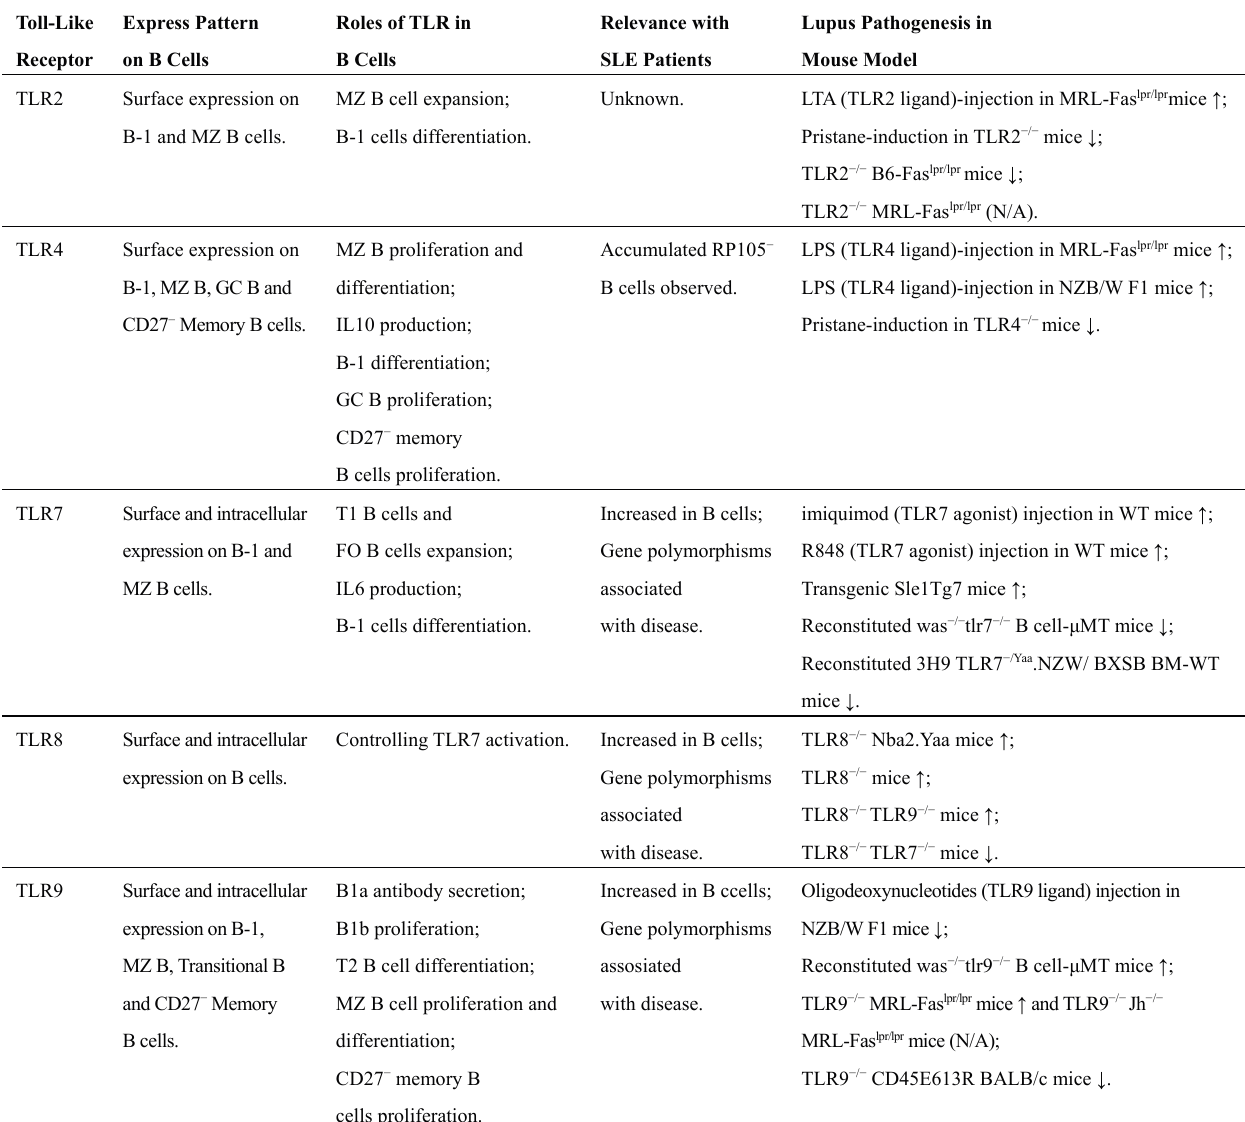
Table 1. TLRs in B cells and lupus